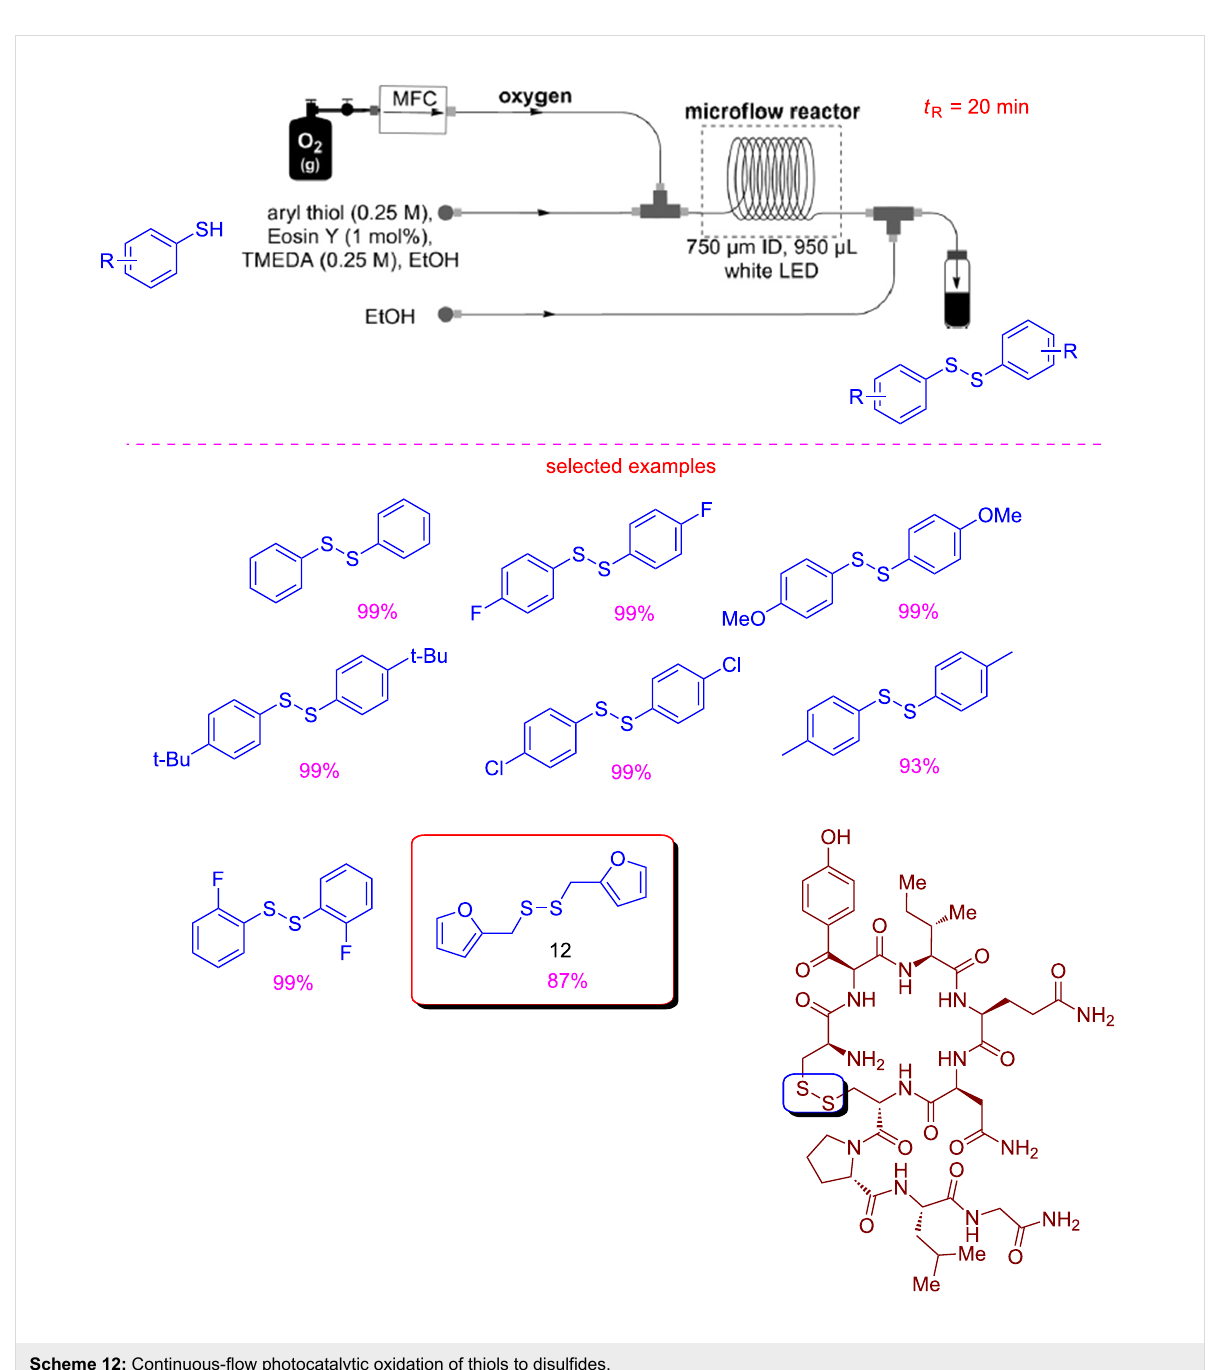
Scheme 12: Continuous-flow photocatalytic oxidation of thiols to disulfides.